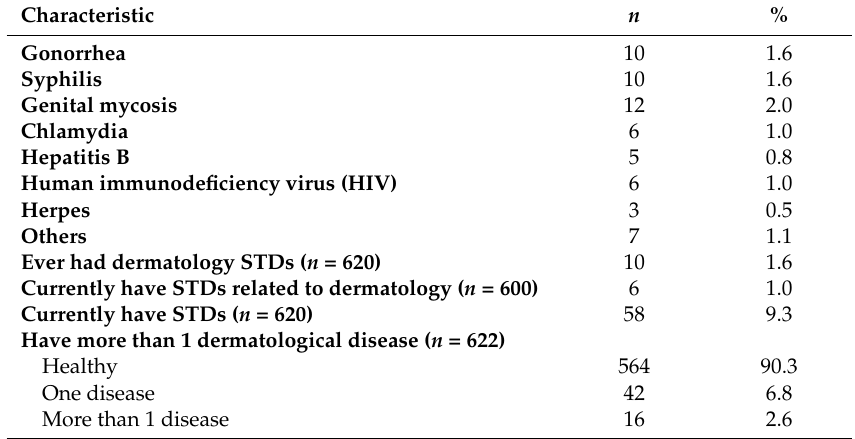
Table 1. Clinical characteristics of respondents. STDs: sexually transmitted diseases.